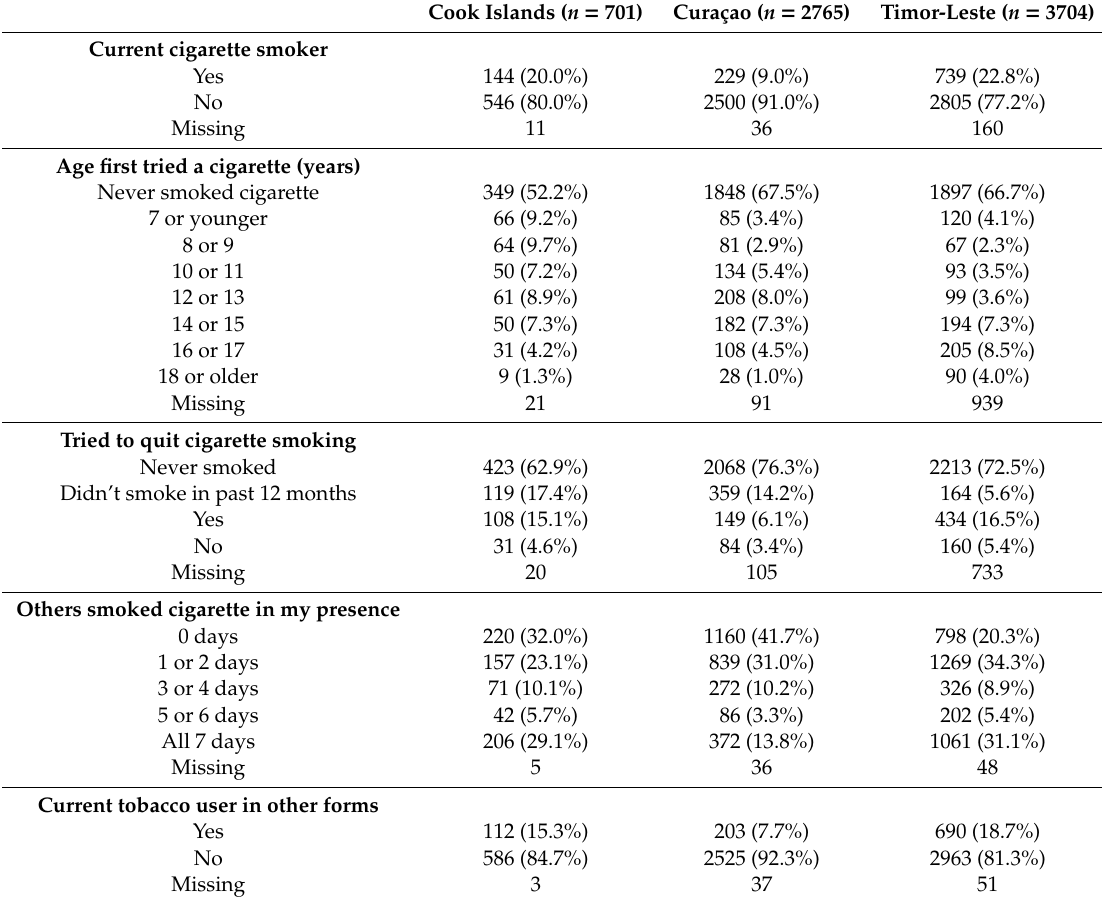
Table 1. Descriptive statistics of tobacco use and cigarette smoking in school attending adolescents. Cook Islands ( n = 701) Curaçao ( n = 2765) Timor-Leste ( n =